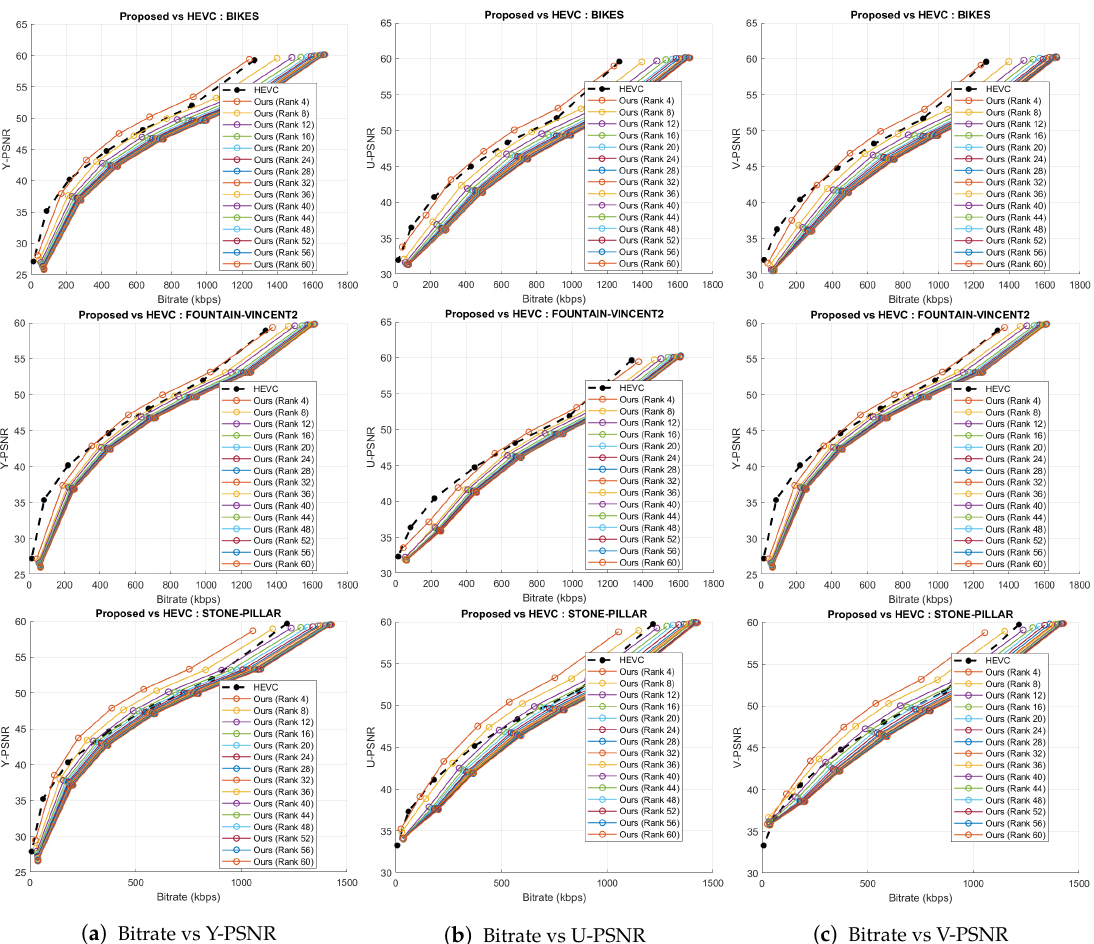
Figure 12. Rate-distortion curves for the proposed compression scheme and HEVC codec for the three